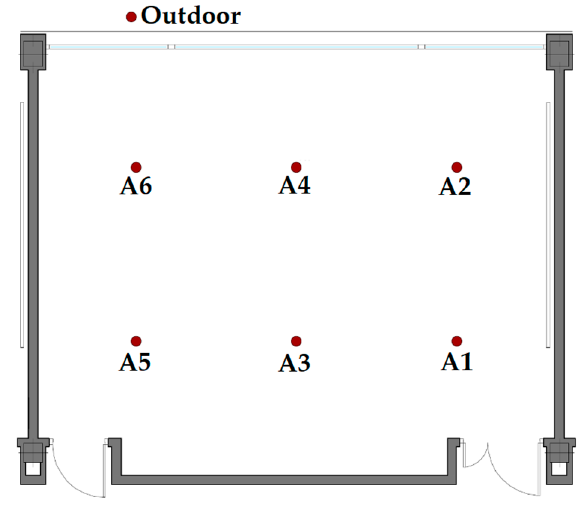
Figure 2. Measuring matrix in the classrooms.